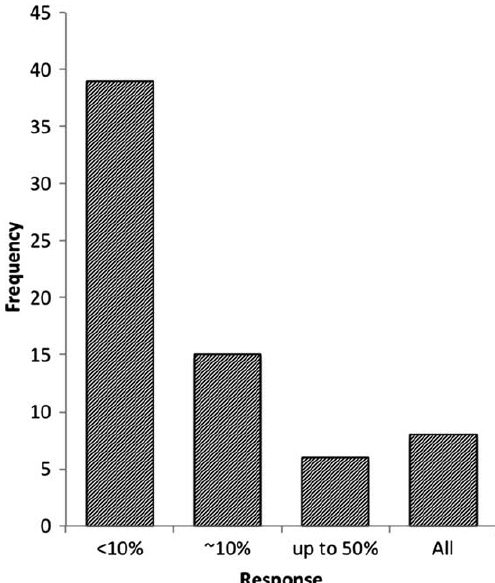
Figure 5. Analysis of students who contacted staff for